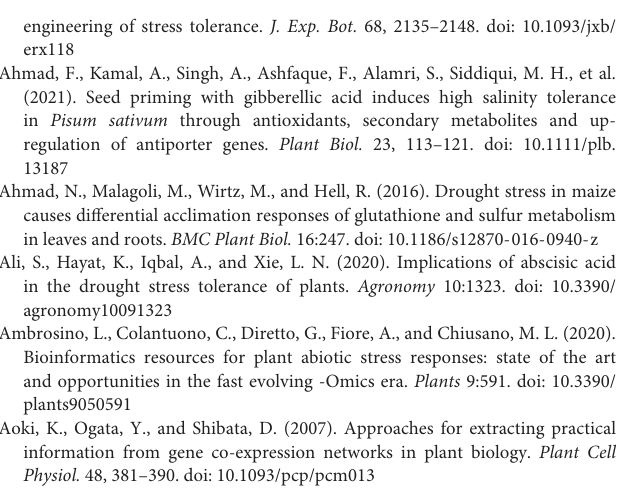
Supplementary Figure 1 | Heatmap cluster of expression in different tissues (leaf, root, and seed) under drought and salt stress conditions in cotton using log2FC. Supplementary Figure 2 | Venn diagram showing the number of shared and unique genes in DEGs of drought and salt stress data in the root, leaf, and seed